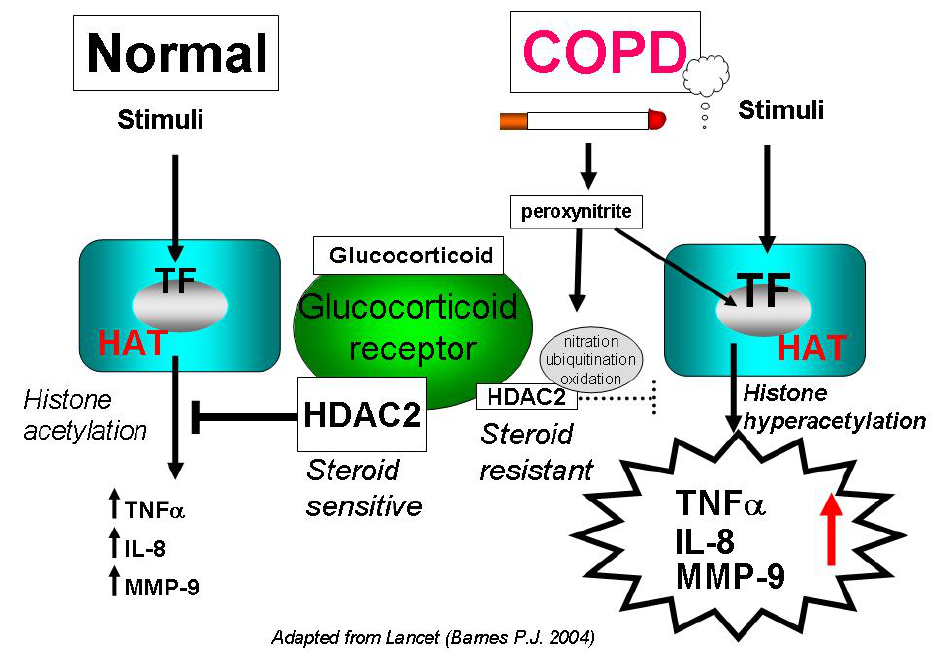
FIGURE 5. Proposed mechanism of glucocorticoid insensitivity in COPD patients. In normal alveolar macrophages, NF- κ B and other transcription factors are activated following stimulation, and switch on HAT, leading to histone acetylation